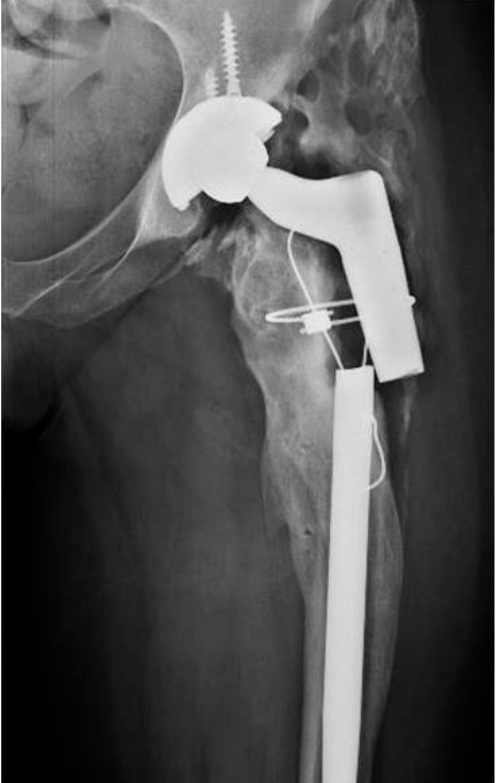
Figure 3. Hip radiography showing diffuse osteomyelitis of the proximal femur and femoral stem rupture.